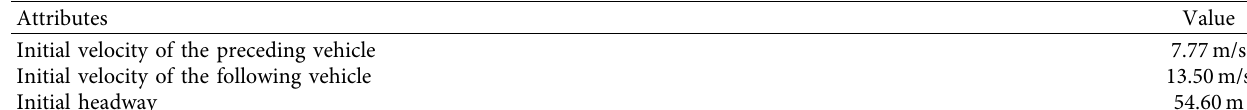
Figure 15: Hysteresis loops comparison of continuous traffic flow. (a) Conventional model; (b) ANN CF (based on the acceleration); (c) ANN CF (based on the velocity). Table 5: Attribute settings of discontinuous traffic flow.